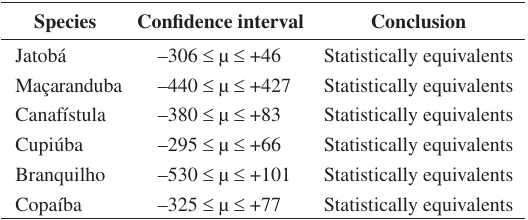
Table 3. Confidence intervals of average differences: E (MPa) for 25 and